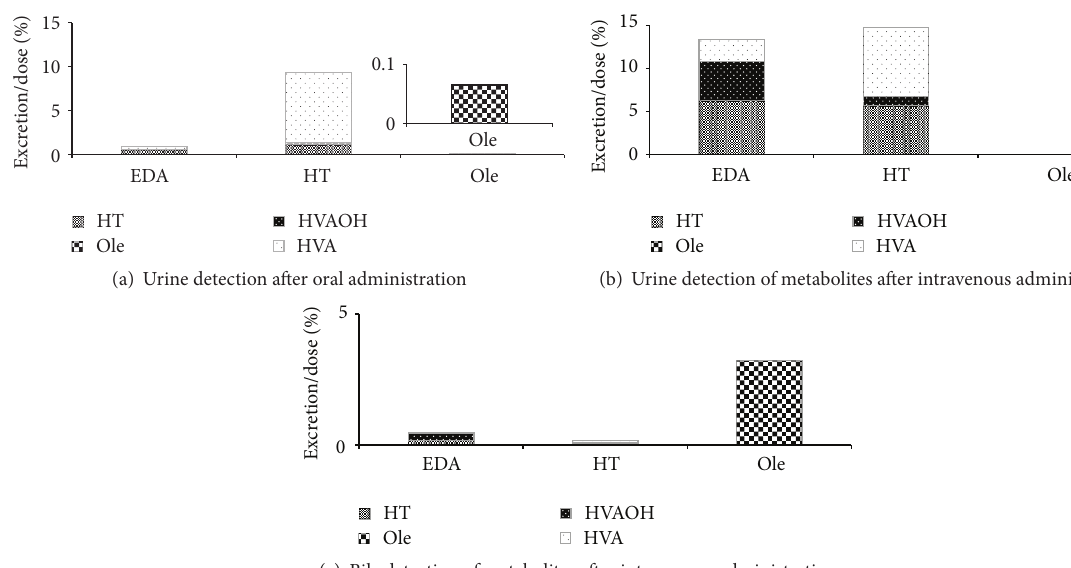
Figure 3: Monitoring of metabolites in urine and bile after oral and intravenous administration of 3,4-DHPEA-EDA, hydroxytyrosol, and oleuropein. Excretion rates are expressed as excretion/dose ratios. EDA: 3,4-DHPEA-EDA, HT: hydroxytyrosol, Ole: oleuropein, HVA: homovanillic acid, and HVAOH: homovanillyl